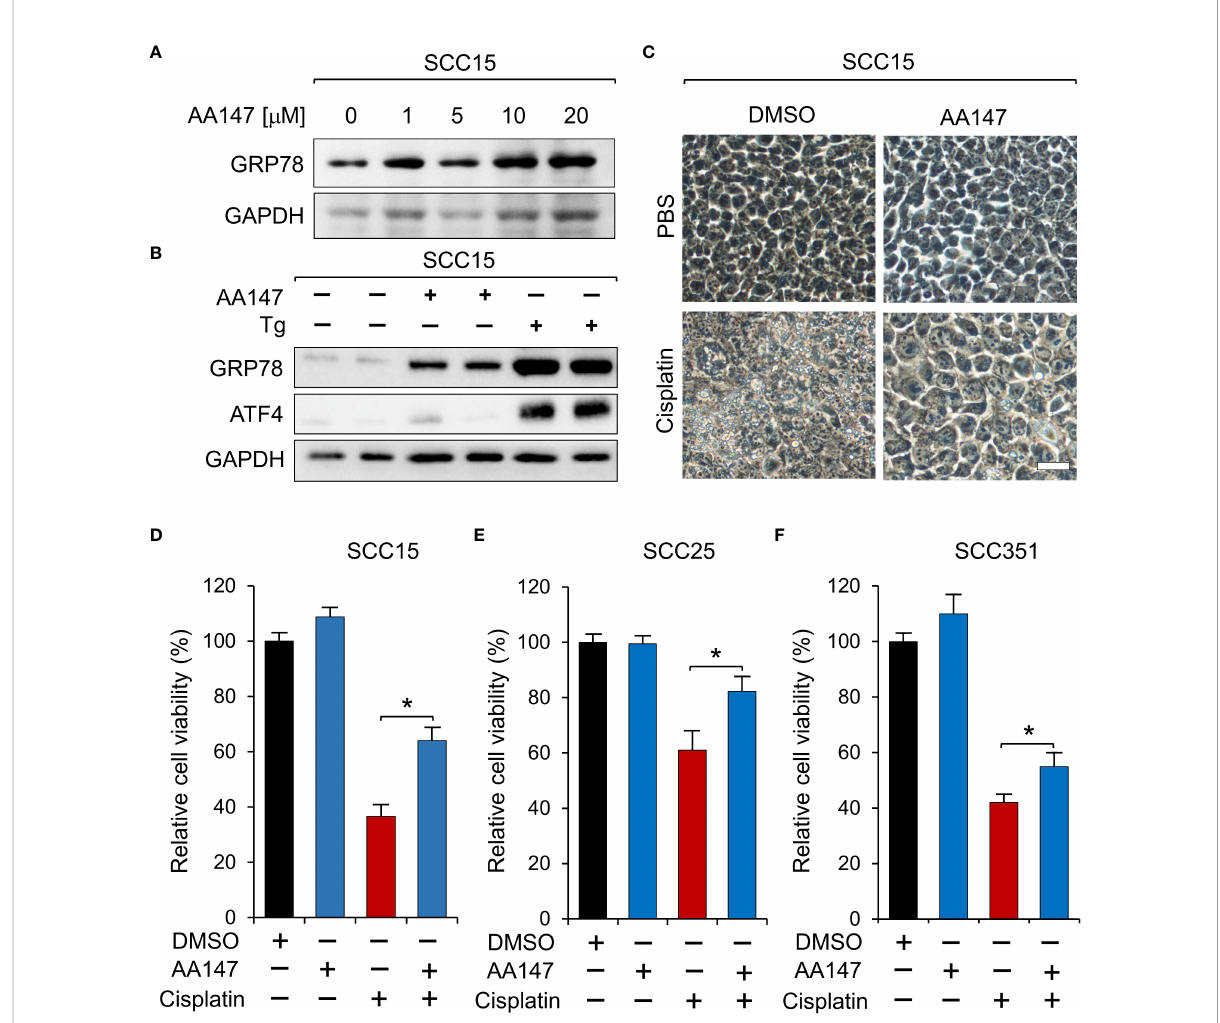
FIGURE 4 Upregulation of GRP78 attenuates sensitivity to cisplatin in HNSCC cell line. (A) SCC15 cells were treated with increasing doses of AA147, or dimethyl sulfoxide (DMSO) as control, for 48 hr and the GRP78 protein level was determined by Western blot, with GAPDH serving as loading control. (B) SCC15 cells were treated with either 10 m M AA147 or 300nM of the ER stress-inducer thapsigargin (Tg) for 48 hr. The GRP78 and ATF4 protein levels were determined by Western blot, with GAPDH serving as loading control. (C) Representative images of SCC15 cells treated with 12 m M cisplatin or 10 m M AA147 alone or in combination for 48 hr. Scale bar = 50 m m. (D) Same as (C) except cell viability was determined by WST-1 assay. (E) Same as in (D) except SCC25 cells were used. (F) Same as (D) except SCC351 cells were treated with 50 m M cisplatin. Data are presented as means ± S.D. (n=3). * P ≤ 0.05 (Student ’ s t